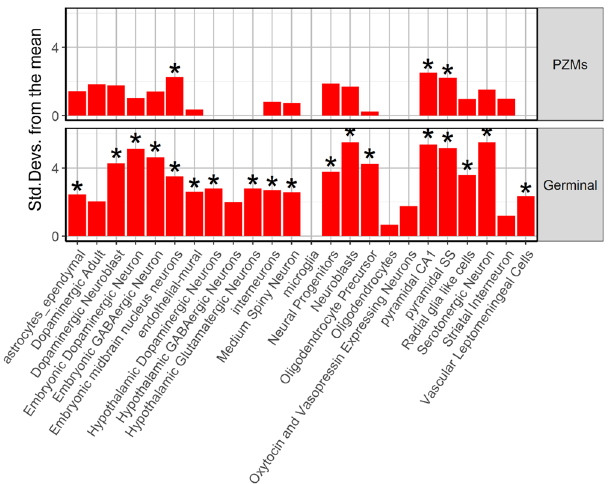
Figure 5. Expression Weighted Cell type Enrichment for PZM and germinal genes.